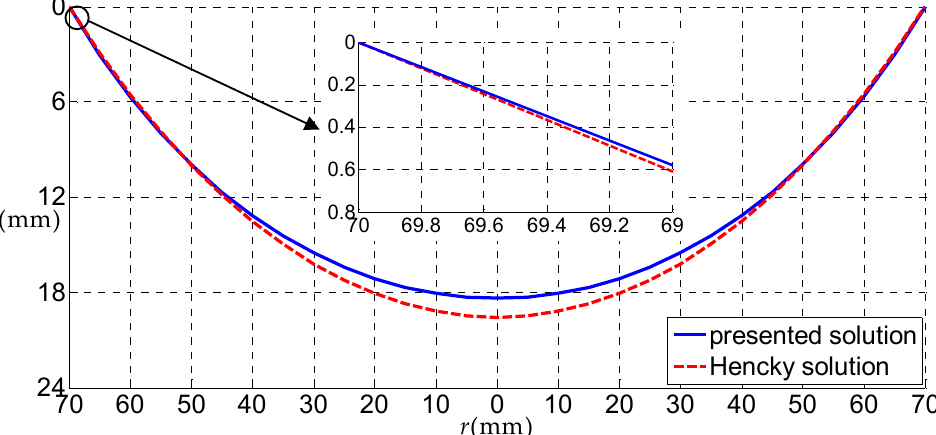
Figure 7. The variations of w with r when q = 0.05 MPa.